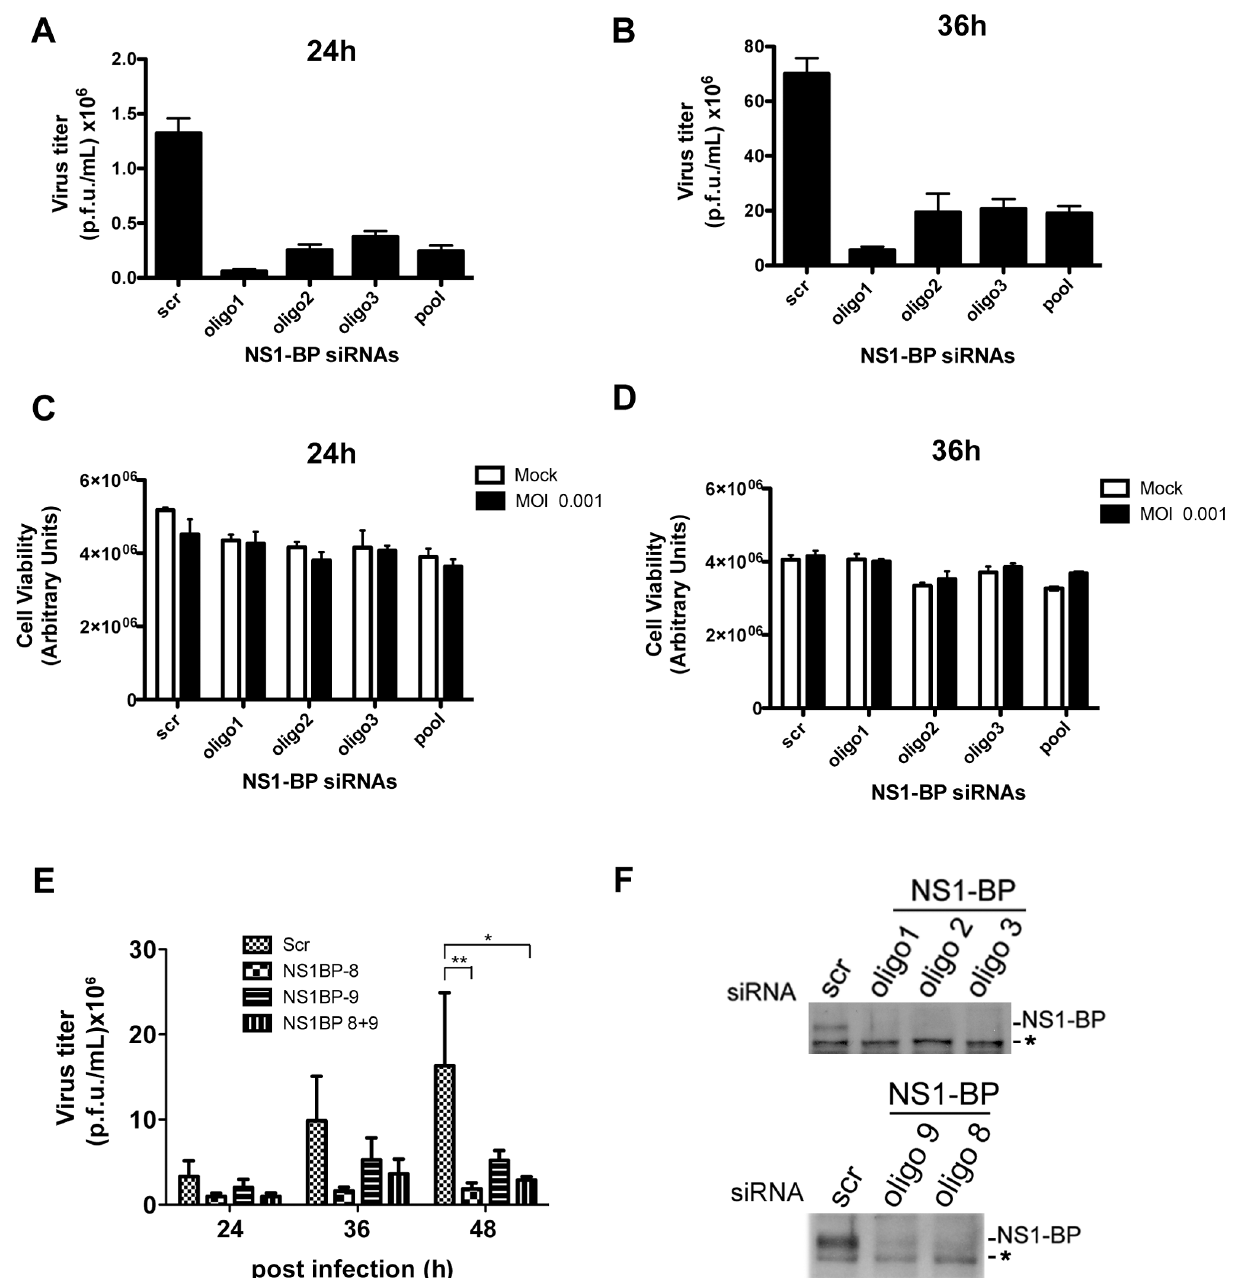
Figure 5. NS1-BP is required for optimal influenza A virus replication. (A) and (B) A549 cells were transfected with non-targeting or NS1-BP siRNAs for 48 h and infected with A/WSN/33 at MOI 0.001. Supernatants were harvested at 24 h and 36 h post-infection, and virus titer was determined by plaque assay. (C) and (D) After removal of supernatants from plaque assays in A and B, the remaining cells were used to measure ATP levels, at 24 h and 36 h post-infection, to determine cell viability. (E) Human bronchial epithelial cells (HBEC) were transfected and infected as in A except that different NS1-BP siRNAs were used. Supernatants were subjected to plaque assay. (F) Cell extracts from A549 cells transfected with siRNAs as in A and HBEC transfected with siRNAs as in E were subjected to immunoblot analysis with anti-NS1-BP antibodies. * denotes a cross-reacting band that serves as loading control. *p , 0.05, **p , 0.01. doi:10.1371/journal.ppat.1003460.g005 analysis at a 1:4000 dilution. hnRNP A1 monoclonal antibody (a hnRNPs K and L antibodies (abcam) were used at dilutions 1:3000 gift from Dr. Michael Matunis, Johns Hopkins School of Public and 1:2000, respectively. E1B-AP5 polyclonal antibody (Protein- Health, MD) was used at a dilution 1:1000. NFAR polyclonal tech Group Inc) was used at a 1:2000 dilution. DHX9 monoclonal antibody (Abnova) was used at a 1:500 dilution. RNA polymerase School of Medicine, FL) was used at a dilution 1:2000. hnRNP U II monoclonal antibody, clone CTD4H8, recognized both phosphorylated and non-phosphorylated forms (Millipore), was monoclonal antibody (ImmuQuest) was used at a 1:1000 dilution.